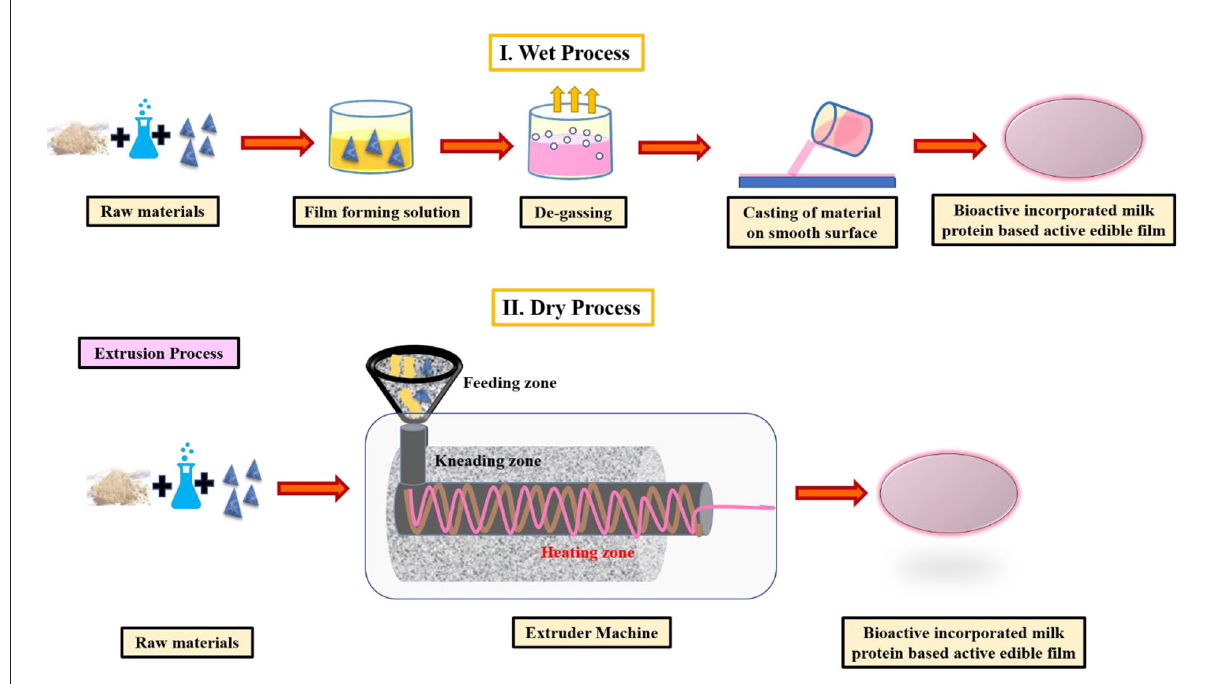
FIGURE3 Wet and dry process (e.g., extrusion) for production of milk protein based active edible films